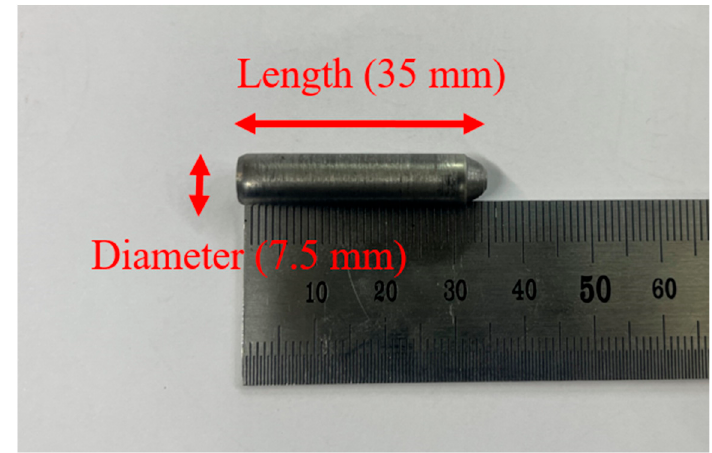
Figure 1. The projectile used in the experiment.